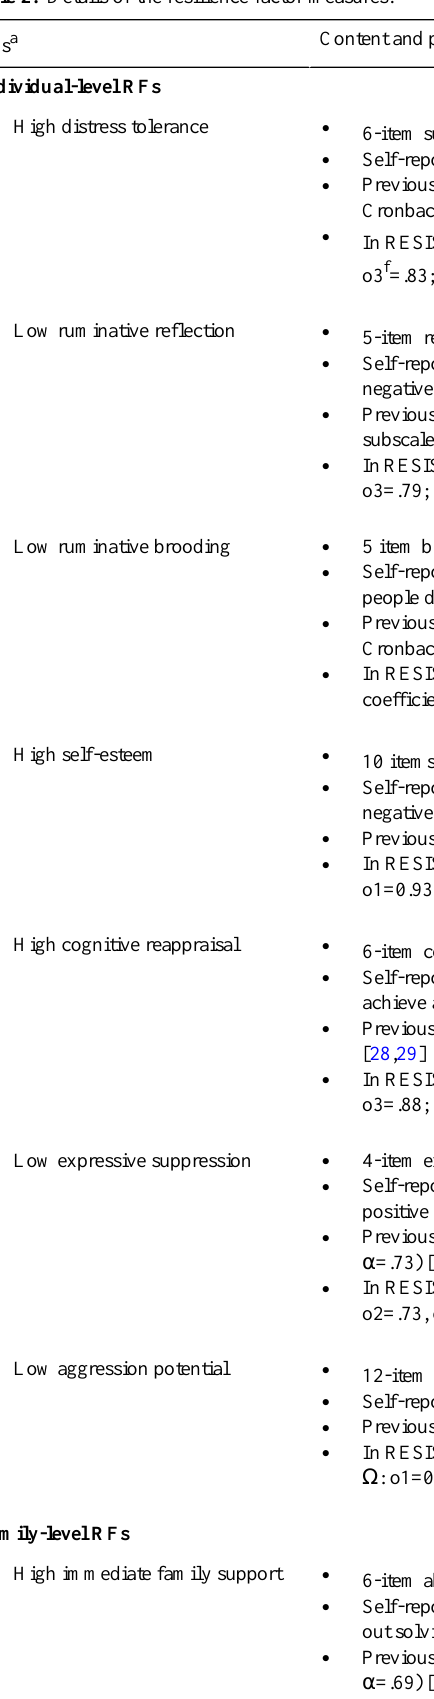
Content and psychometric informationRFs a